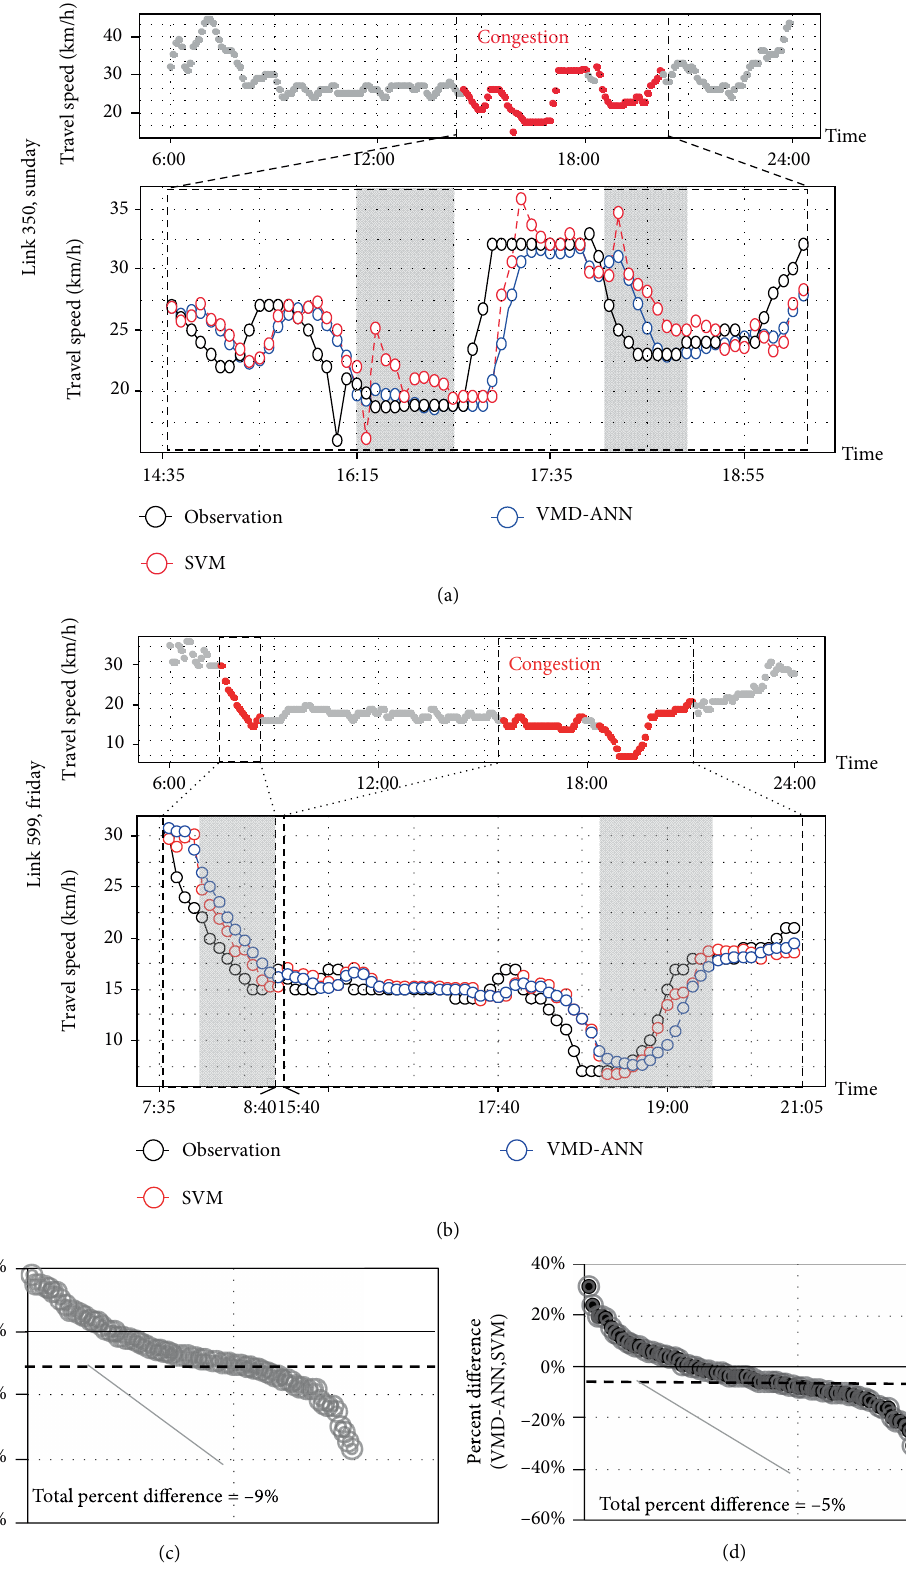
Figure 5: Detailed comparison of SVM’s and VMD-ANN’s predicted values in congestion: (a) VMD-ANN’s predicted value is better than SVM’s, (b) VMD-ANN’s predicted value is worse than SVM’s. Variation of the percent difference between SVM and VMD-ANN by different link-day, (c) MAPE, and (d)